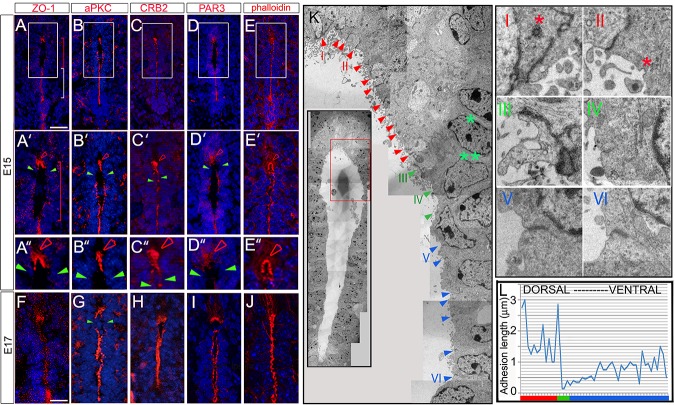
Apical polarity proteins and tight junctions are reduced on delaminating VL cells.(A-E″) Transverse sections through spinal cord of E15 mouse embryos immunolabelled as indicated. (A′-E′) show high-magnification views of boxed regions shown in (A-E); (A″-E″) show high-magnification views of regions indicated by arrowheads in (A′-E′). High expression of apical polarity proteins and the tight junction protein, ZO-1, are detected on the endfeet of dmNes+RG (open red arrowheads) but not detected (ZO-1, aPKC, PAR3) or barely detected (CRB2) on immediately adjacent dVL cells (green arrowheads). Phalloidin is expressed strongly on dmNes+RG and in a punctate manner throughout dVL cells. (F-J) At E17, junctional and polarity proteins likewise show reduced/no expression on VL cells that abut dmNes+RG, but phalloidin is detected in a continuum. White and red brackets show vVL and dVL regions, respectively. (K) EM images of the E15.5 VL; K shows boxed region in inset (dmNes+RG and dVL regions). Red arrowheads point to dmNes+RG; green arrowheads point to delaminating dVL cells; blue arrowheads point to cells ventral to these. Representative images I–VI are shown at high magnification in panels. Green asterisks point to nucleus about to delaminate (double asterisk) or just delaminated (single asterisk). Red asterisks in panels I and II point to secretory vesicles. In vVL regions, the uniform arrangement of nuclei shows that each adhesion complex lies on either side of a cell. (L) Quantitative analysis showing length of electron-dense junctions along a single side of the VL: junction length increases dorsally and ventrally, from delaminating cells. Scale bars: A–J, 100 μm. aPKC, atypical protein kinase C; CRB2, Crumbs2; dmNes+RG, dorsal midline Nestin(+) radial glia; dVL, dorsal ventricular layer; EM, electron microscopy; PAR3, polarity protein PAR3; VL, ventricular layer; vVL, ventral ventricular layer; ZO-1, Zona occludens 1.